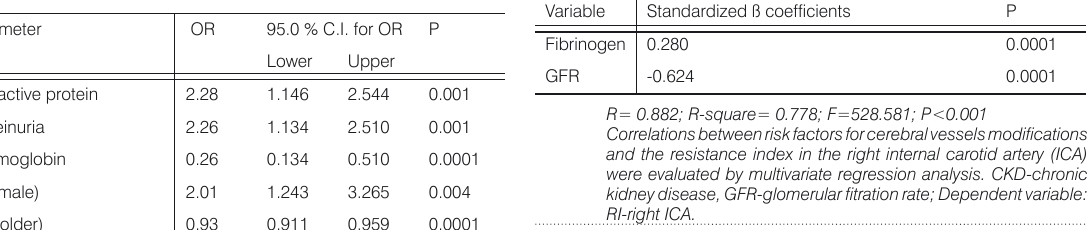
Table 4. Risk factors for localized cerebral vessels lesions (stenoses and occlusions) vs. diffuse atherosclerosis within the CKD(+) group.